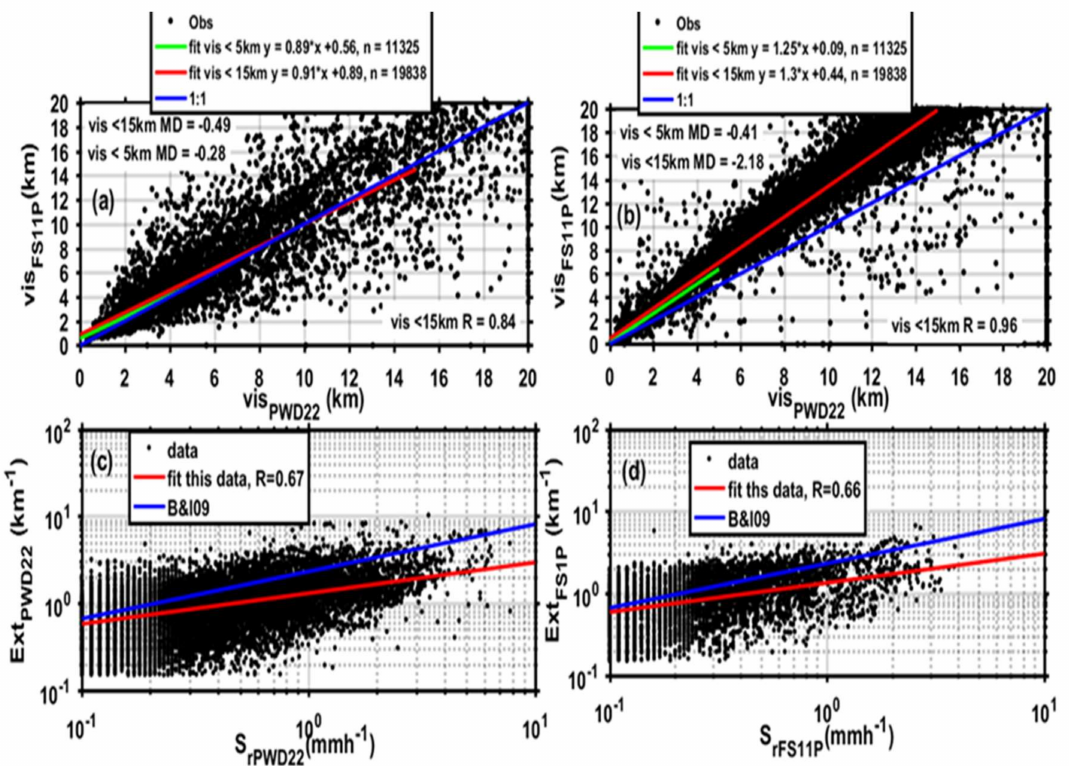
Figure 6. Visibility (VIS) comparison of FS11P and PWD22 during precipitation ( a ), during fog and clear conditions ( b ), the observed extinction (Ext = 3/vis) and snowfall intensity (Sr), and for FS11P ( c ). The data measured using the Vaisala FS11P ( d ) and PWD22, n represent the number of data points at 1 min intervals. The least square fits for this data are based on [17] (B&I09); the mean difference (MD) and the correlation coefficient (R) are also